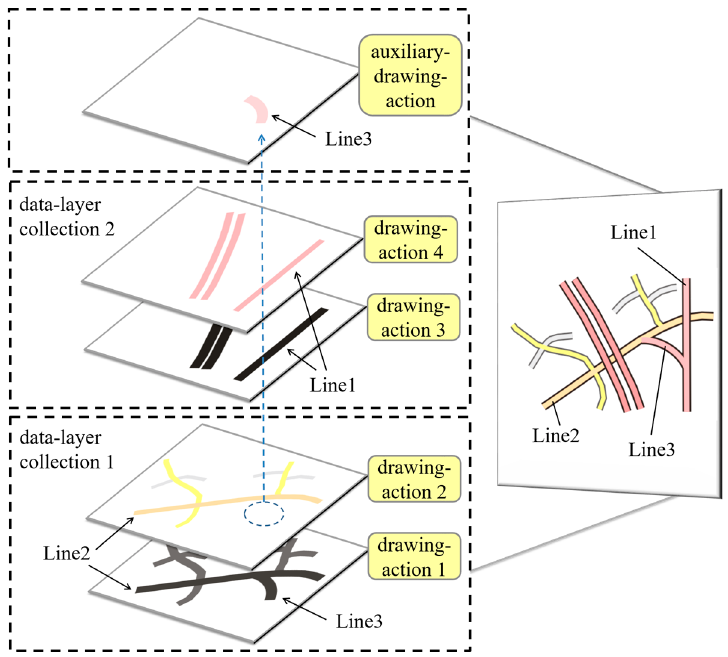
Figure 10. Example rendering process of a road network with a conjunction spatial relationship.